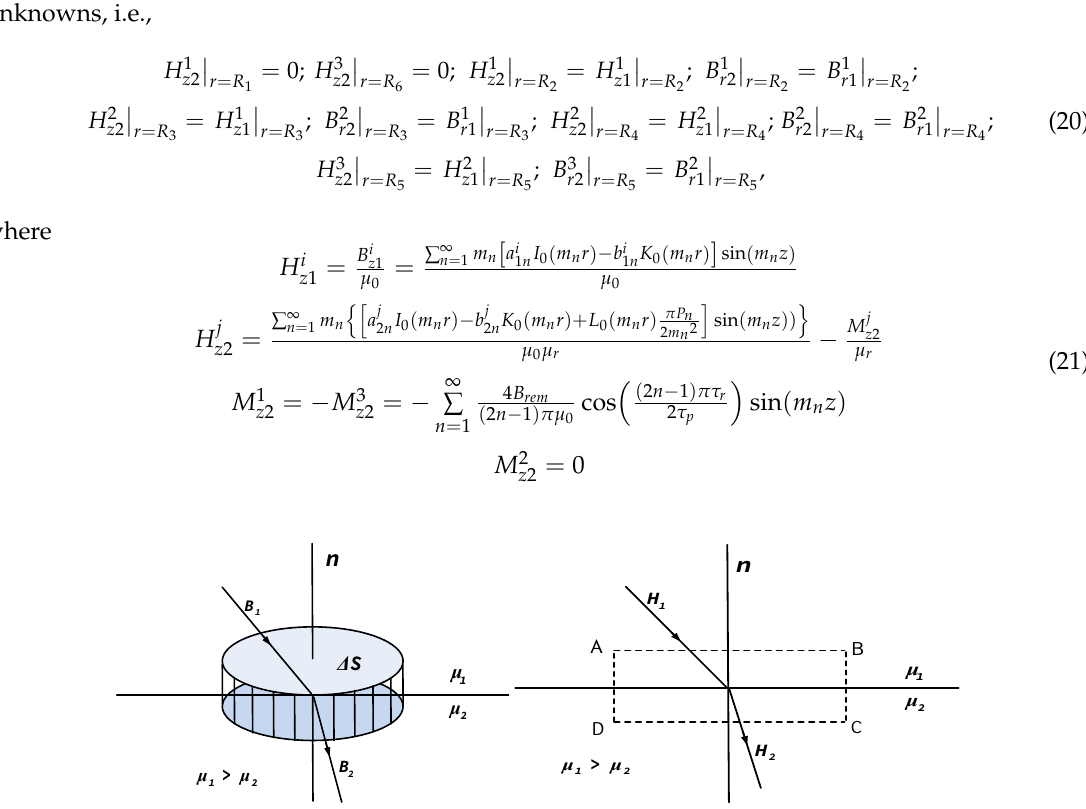
Figure 4. Boundary conditions of flux density and field intensity.